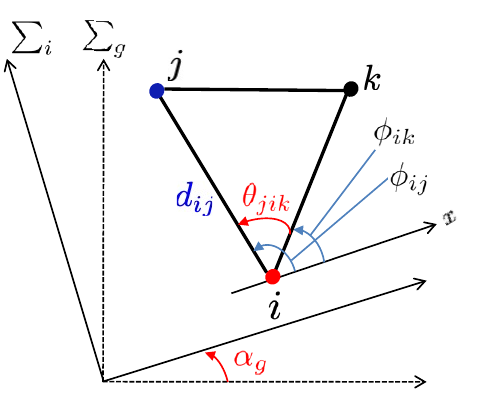
Figure 2. An illustration for the distance and bearing